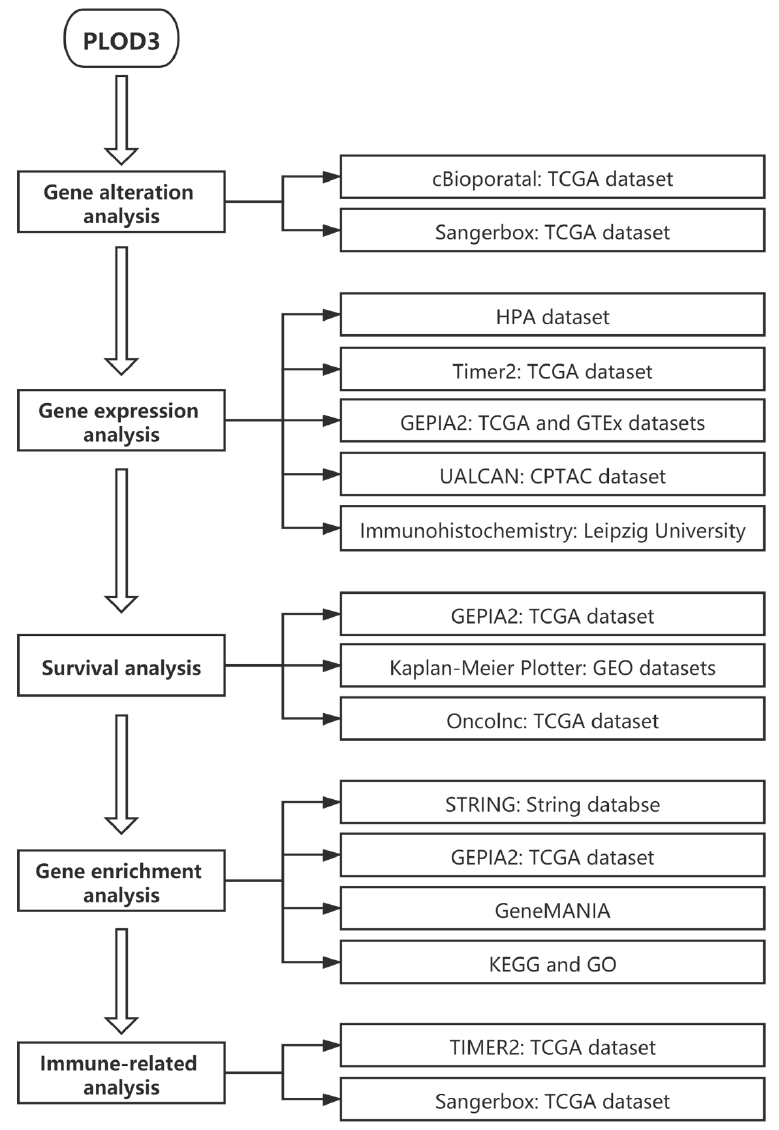
Figure 1. Setup of the integrative and comprehensive pan-cancer analysis of PLOD3.